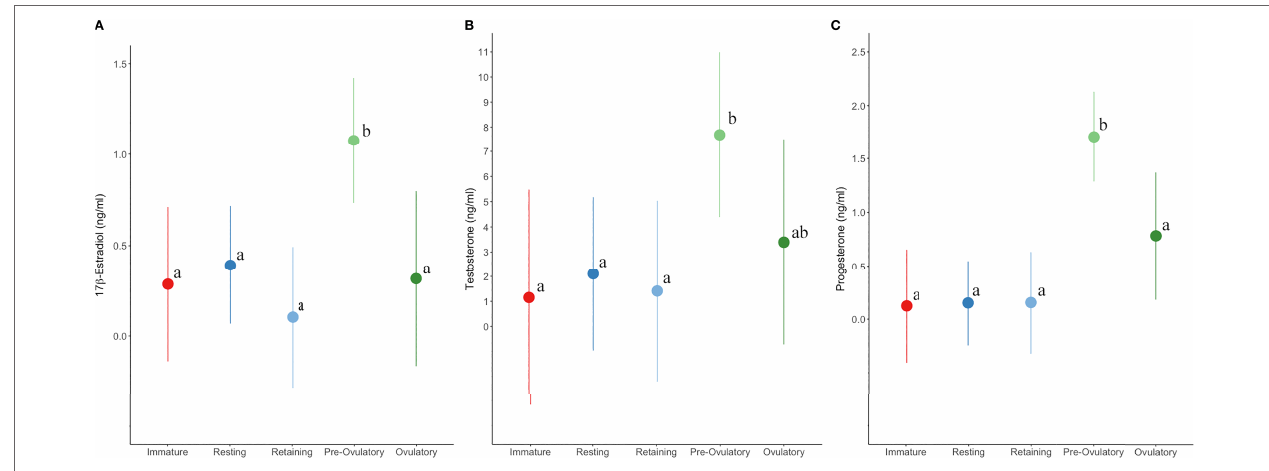
FIGURE 7 | Plasma (A) 17 β -estradiol (B) testosterone (C) and progesterone concentration (marginal mean and 95% confidence interval) by reproductive stage for aquarium sand tiger sharks. Different letters indicate significant ( P < 0.05) differences between stages within each hormone